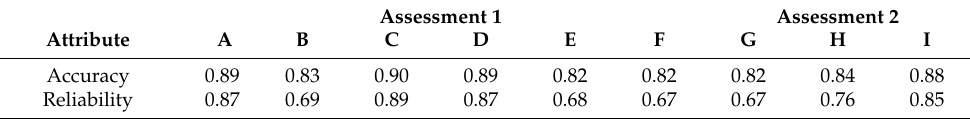
Table 5. Attribute-level classification accuracy and